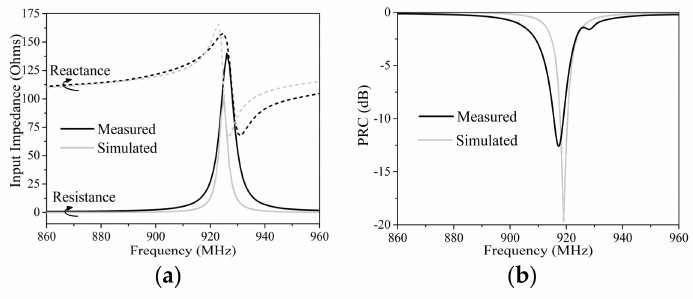
Figure 12. Comparison of the simulated and measured ( a ) input impedance and ( b ) PRC results of the proposed tag antenna without the impact of a